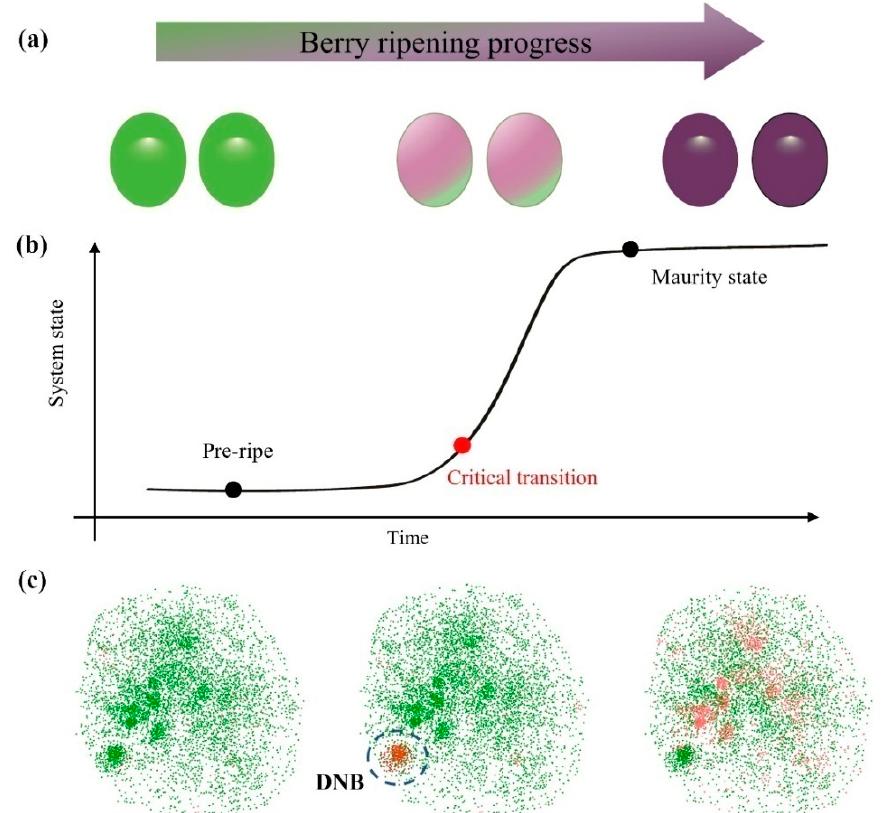
Figure 1. The diagram for the phase transition of berry/fruit ripening process. ( a ) The fruit develop- ment process and fruit ripening from pre-ripe to mature includes three phases. ( b ) The system in the pre-ripening phase and the maturity phase is smooth and steady. Meanwhile, in the critical transition state, the system fluctuates, and the transition driver genes fluctuate in their expression. ( c ) The peak of the PSI index for DNB module indicates the tipping point of the phase transition.